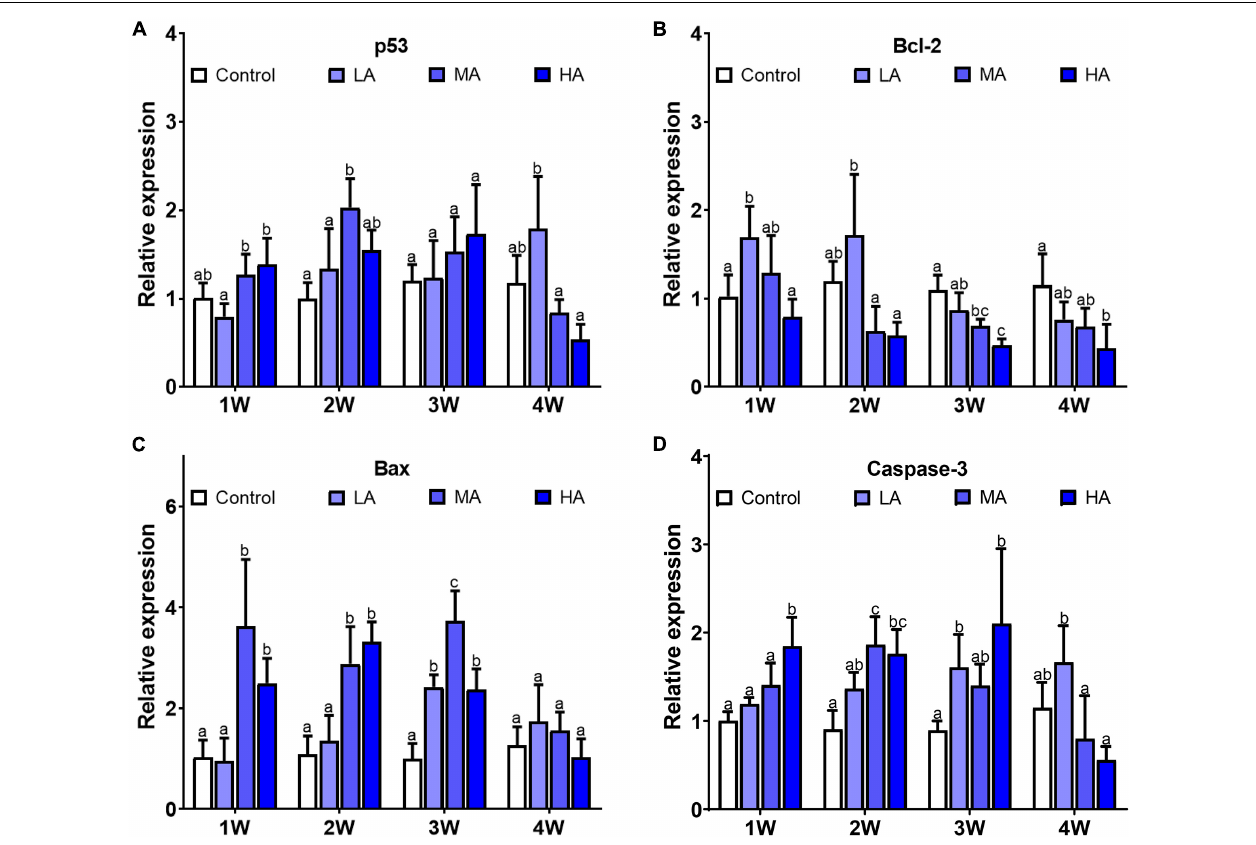
FIGURE 6 | Expression of p53 (A) , bcl-2 (B) , bax (C) , and caspase-3 (D) in different treatments during long-term ammonia stress. Values are means ± S.D ( n = 3). Different letters represent significant differences among different groups ( P <